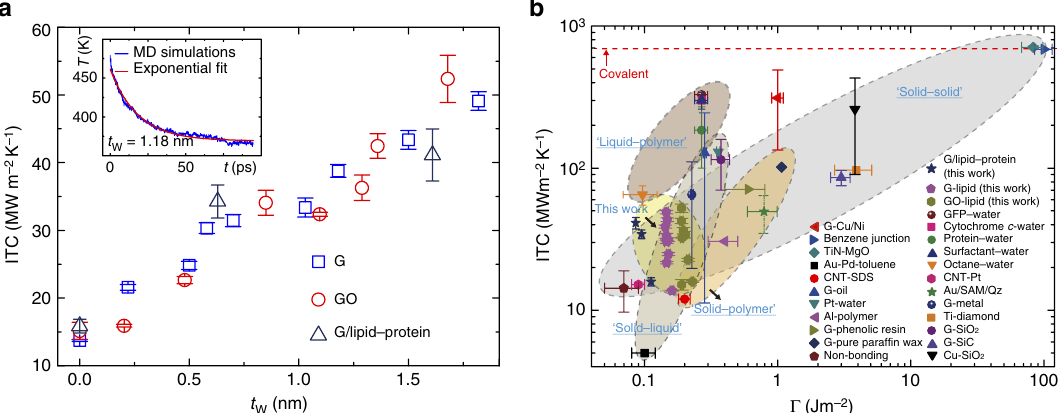
Figure 4 | Interfacial thermal conductance (ITC) in typical systems. ( a ) The ITC plotted as a function of t W . The inset shows the exponential decay of temperature in the graphene layers after the heat pulse is removed, which is used to calculate the ITC in our thermal relaxation simulations. ( b ) A summary of ITC plotted as a function of the interfacial energy G at solid–solid, solid–polymer, liquid–polymer and solid–liquid interfaces. The data are collected from the literature 26–43 .